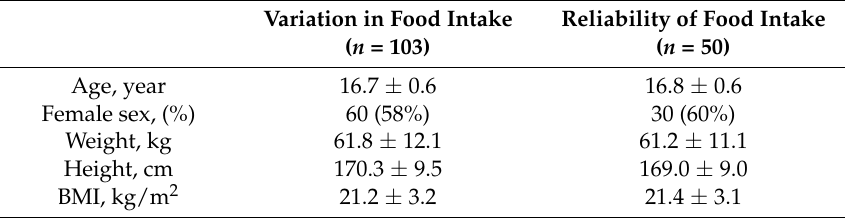
Table 1. Characteristics of students in the variation in food intake and reliability of food intake 1 analyses 2 .